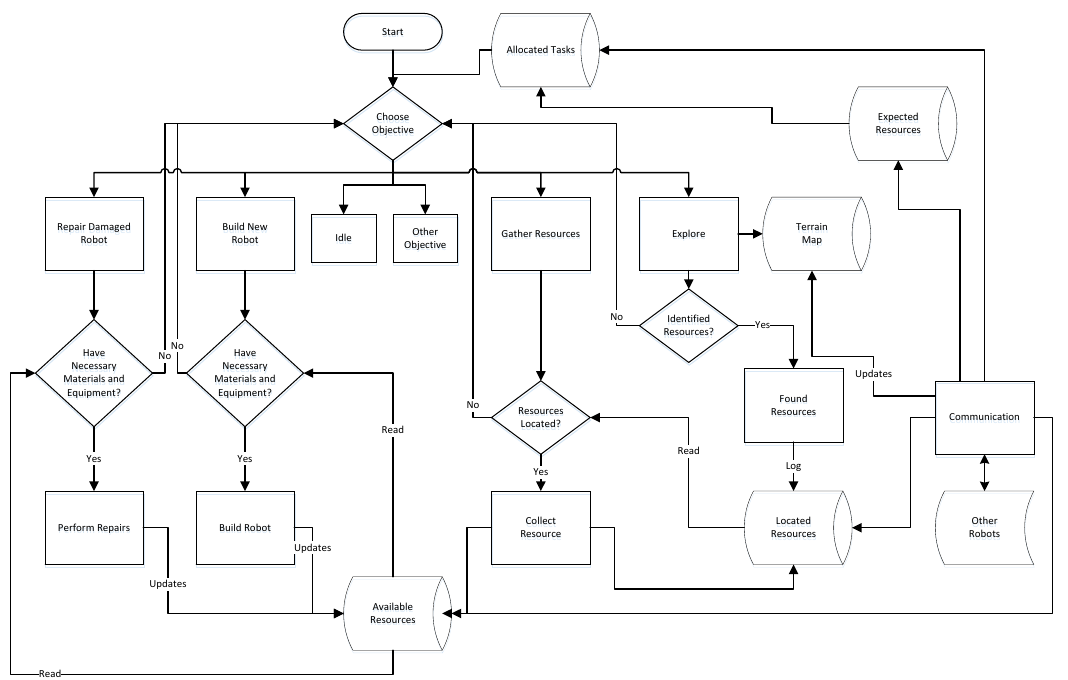
Figure 5. System decision-making diagram.